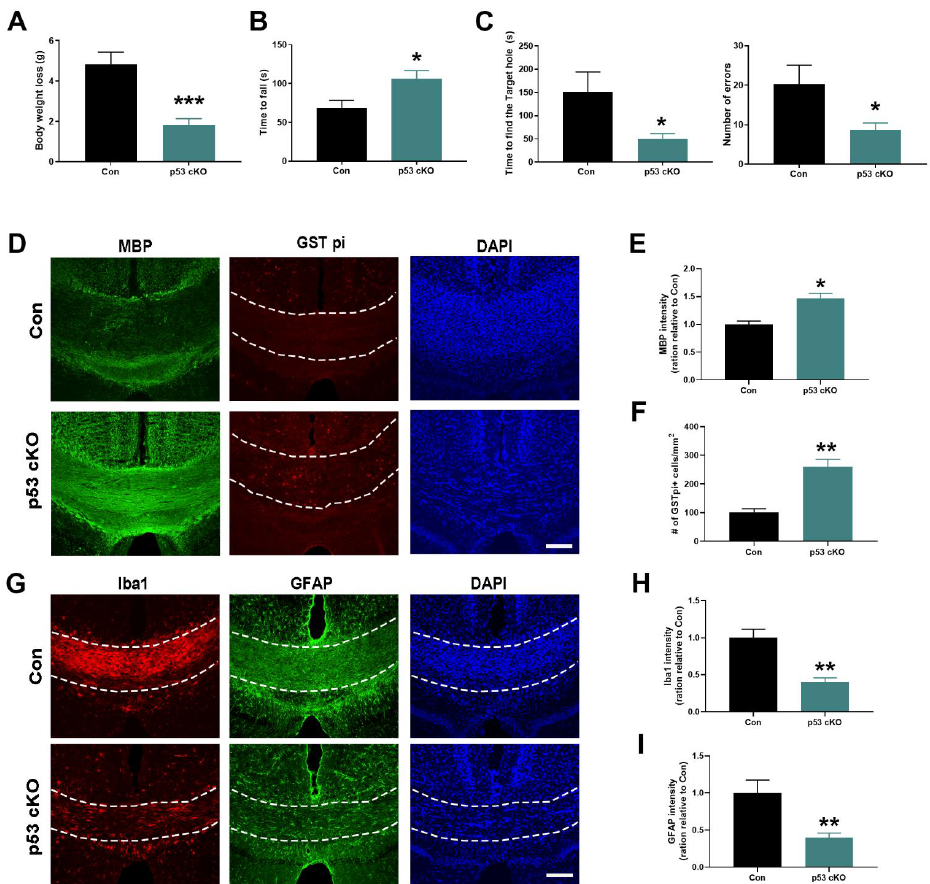
denser in p53 cKO animals compared with control animals after cuprizone intoxication (Figure 3D,E). The results of GST pi (a marker for mature OLs) staining showed that the number of OLs in corpus callosum were significantly higher in p53 cKO animals after a 5-week cuprizone treatment (Figure 3D,F). Consistent with the reduced demyelination, p53 deletion attenuated the activation of astrocytes (GFAP+ cells) and microglia (Iba1+ cells) in the corpus callosum of cuprizone-challenged p53 cKO mice (Figure 3G–I). These results indicate that p53 deletion can provide protective effects for OLs and myelin against Int. J. Mol. Sci. 2021 , 22 , x FOR PEER REVIEW cuprizone intoxication in brain.